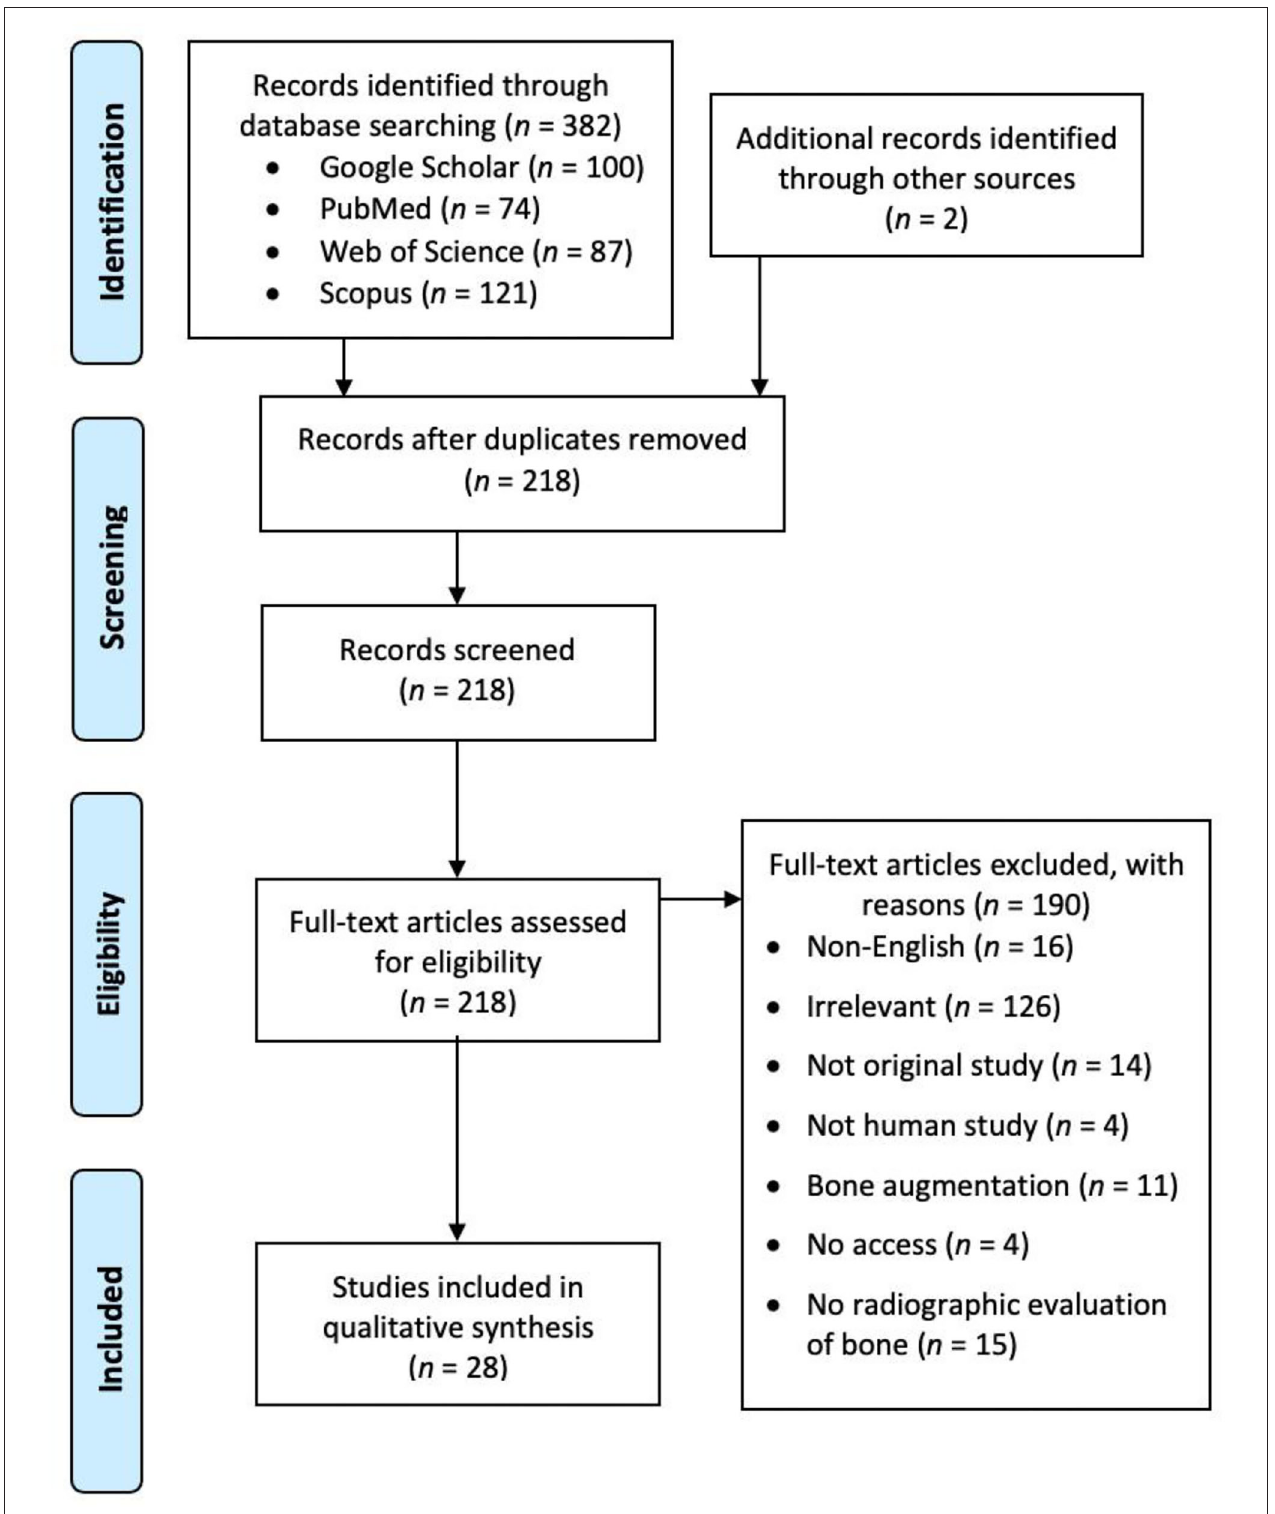
FIGURE 2 | A preferred reporting items for systematic reviews and meta-analyses (PRISMA) flow chart showing the screening process of the literature search.